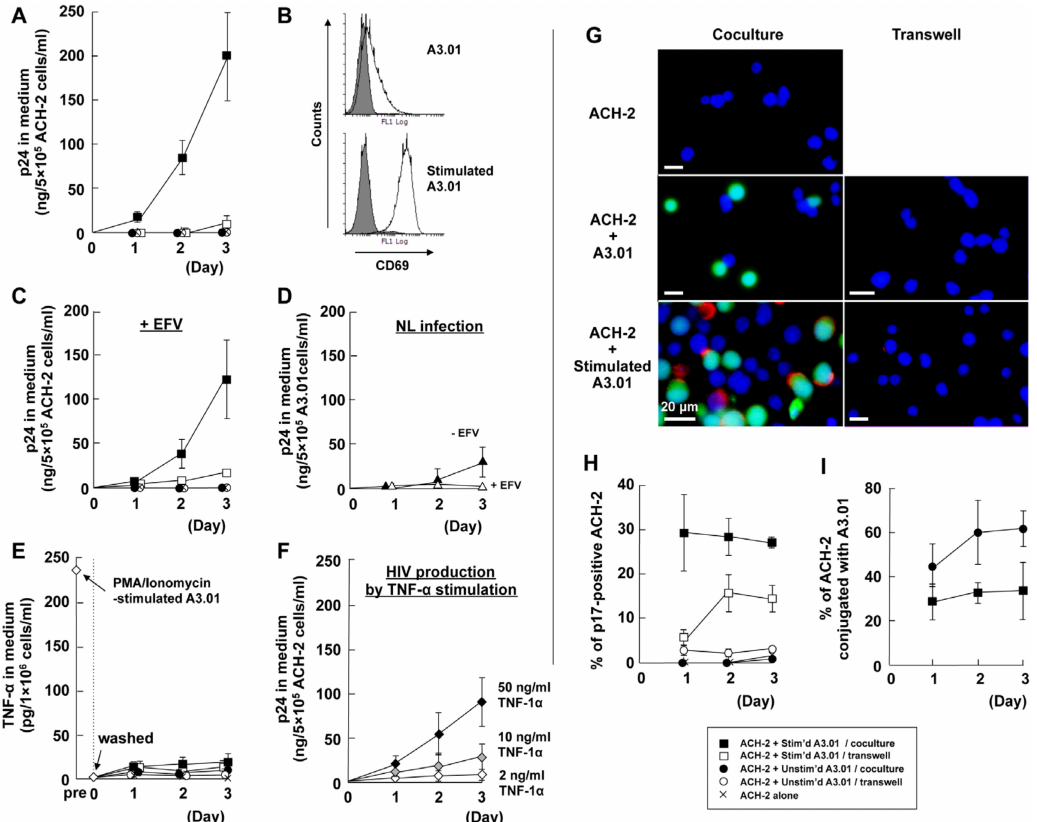
Figure 2. E ffi cient reactivation of HIV-1 in ACH2 cells by cell-to-cell contact with stimulated A3.01 cells. ACH-2 cells were cocultured with unstimulated or stimulated A3.01 cells with cell-to-cell contact. ACH-2 cells were also cocultured with unstimulated or stimulated ACH-2 cells without cell contact in a transwell system. ( A ) HIV-1 p24 production to culture medium. The levels of HIV-1 p24 antigens were measured by HIV-1 p24CA antigen capture ELISA. Data are the mean of two duplicate experiments. ( B ) CD69 expression on the cell surface. Stimulated and unstimulated A3.01 cell surfaces were immunostained with anti-CD69 mAb and analyzed by FCM. Gray-shaded histograms show negative controls. ( C ) HIV-1 p24 production to culture medium in the presence of EFV. Cells were cocultured as described in (A) in the presence of EFV. ( D ) HIV-1 p24 production to culture medium from acutely infected A3.01 cells. A3.01 cells were infected with HIV-1 (the NL strain) at a multiplicity of infection of 2 and were cultured in the presence or absence of EFV. ( E ) TNF- α production to culture medium. The levels of TNF- α were measured by ELISA. The levels of TNF- α one day after PMA / ionomycin stimulation and subsequent cell washing were also shown. ( F ) HIV-1 p24 production by TNF- α stimulation. ACH-2 cells were stimulated with TNF- α and the levels of HIV-1 p24 production were measured by HIV-1 p24CA antigen capture ELISA. ( G ) Expression of HIV-1 p17MA antigen. ACH-2 cells were prelabeled with CellTracker (green) when cocultured with A3.01 cells with cell contact. The cell mixtures were subjected to immunostaining with anti-HIV-1 p17MA mAb (red) and DAPI (blue). In the transwell cell culture, unlabeled ACH-2 cells were placed in the lower compartments and A3.01 cells in the upper compartments. The ACH-2 cells in lower compartments were immunostained. All images were at 2 days post coculture. Scale bar, 20 µ m. ( H ) Reactivation e ffi ciency of latent HIV-1 in ACH-2 cells. The ACH-2 cells immunostained for HIV-1 p17MA in ( G ) were subjected to quantification for reactivation e ffi ciency. The rates of HIV-1 p17MA-positive ACH-2 cells in 100–150 ACH-2 cells were calculated. Data are the mean ± SD from three independent experiments. ( I ) Conjugation e ffi ciency of ACH-2 with A3.01 cells. The rates of ACH-2 conjugated with A3.01 cells in 100–150 ACH-2 cells were calculated. Data are the mean ± SD from three independent